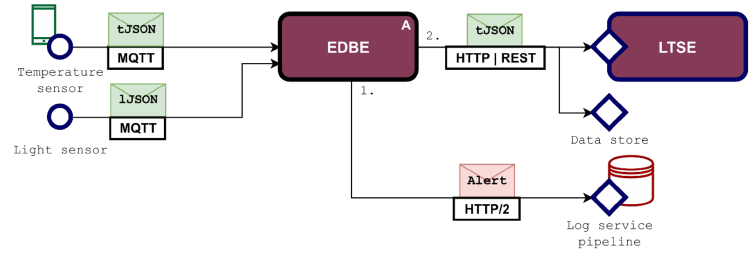
Figure 6. ASSIST-IoT data view—example data pipeline.